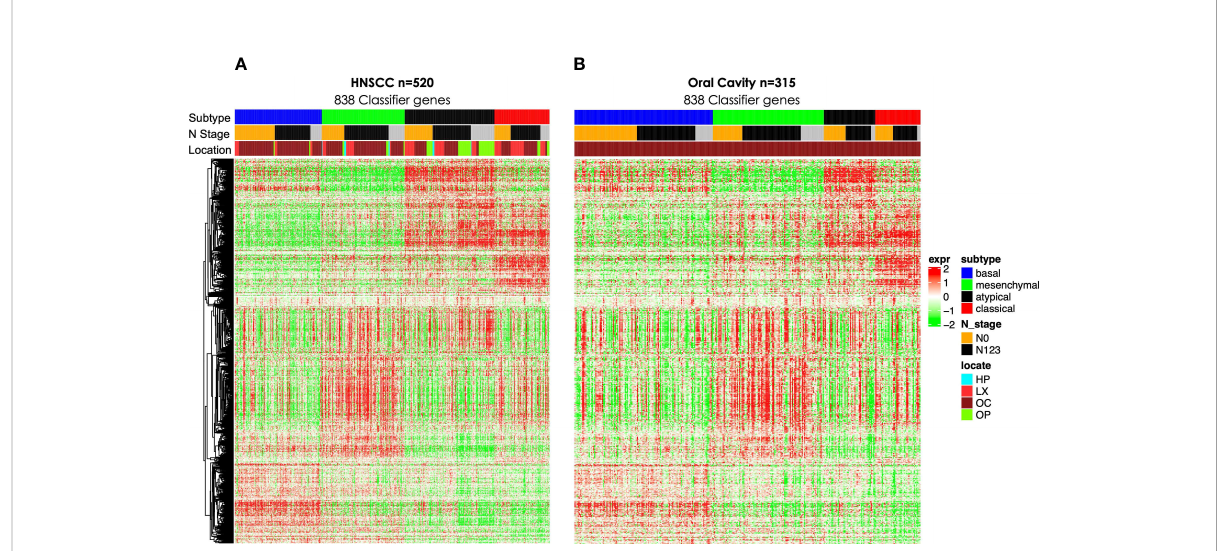
FIGURE 1 Gene expression heat maps including 838 gene classi fi er genes as described previously (5) for (A) all TCGA HNSCC (n = 520) and (B) OC (n = 315). TCGA, The Cancer Genome Atlas; HNSCC, head and neck squamous cell carcinoma; OC, oral